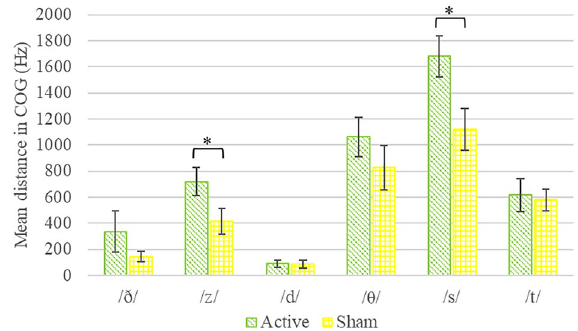
Figure 4. Mean distance scores of COG (center of gravity) values of consonants in the active and sham stimulation groups. Mean distance scores were calculated as the absolute value of the difference between post- and pre-training values. Error bars represent standard error of the mean. * p <